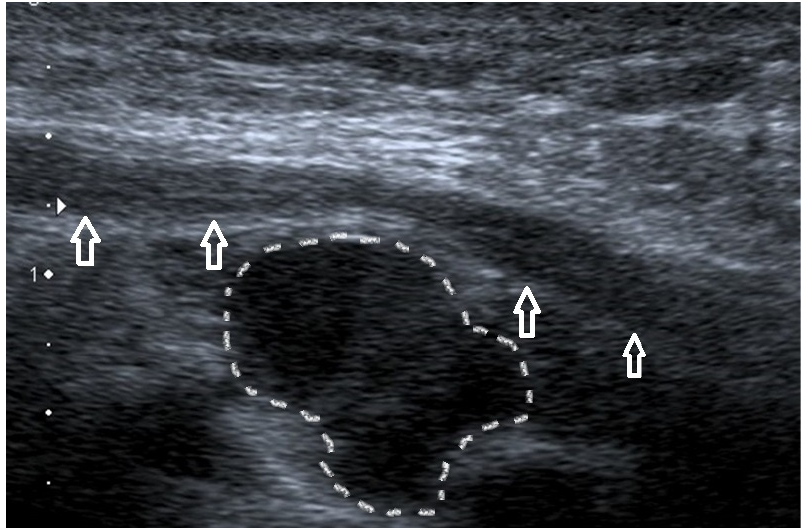
Figure 11. Ganglion cysts (dotted line) compressing the ulnar nerve